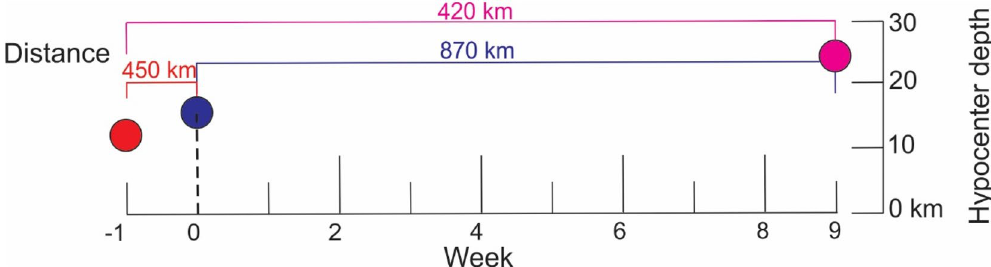
Figure 3. Distance, hypocenter depth and time occurrence of the 2012 earthquakes in El Salvador (red), Costa Rica (blue) and Guatemala